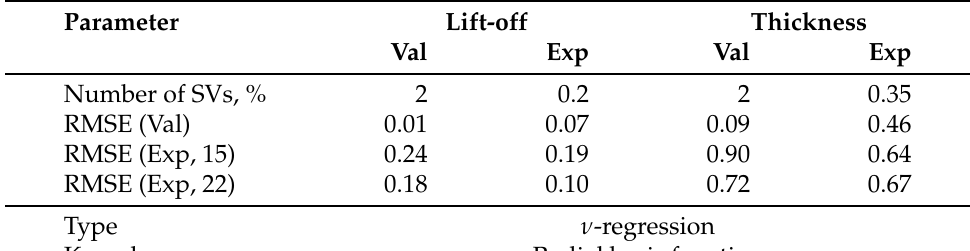
Table 4. Parameters of SVM models and corresponding RMSE values (Val model optimized using simulated validation set, Exp model optimized using the experimental